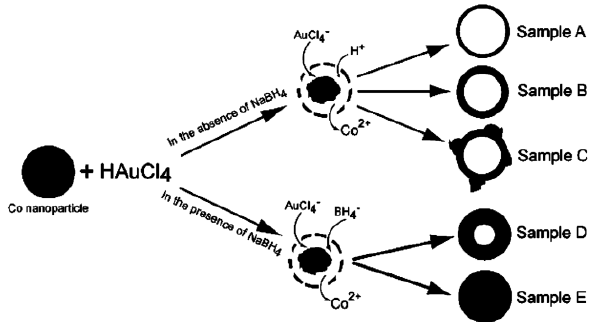
Figure 10. Synthesis of hollow gold nanoshells; role of NaBH 4 in shell build-up. Reprinted with permission from Reference [64]. Copyright (2005) American Chemical Society.